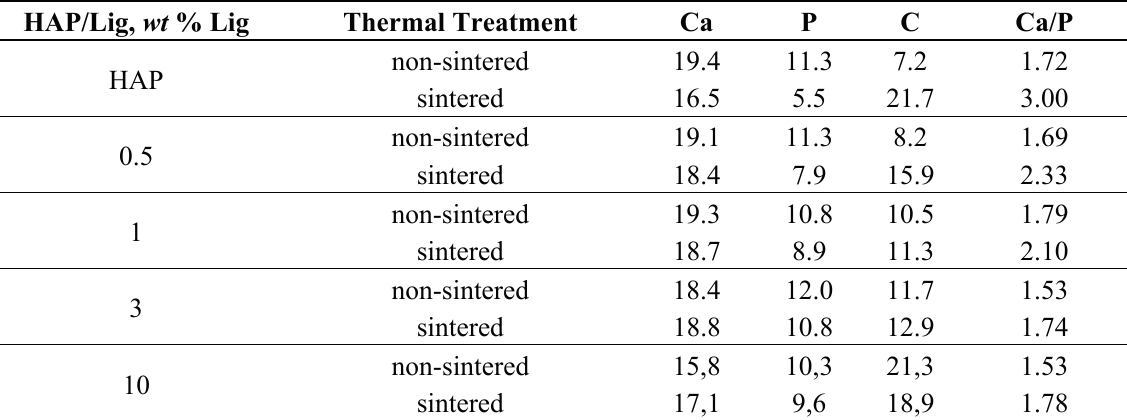
Table 1. Quantitative XPS analysis data for HAP and HAP/Lig (0.5–10) wt % Lig coatings Reprinted from [38] with permission. Copyright Elsevier 2012. HAP/Lig, wt %